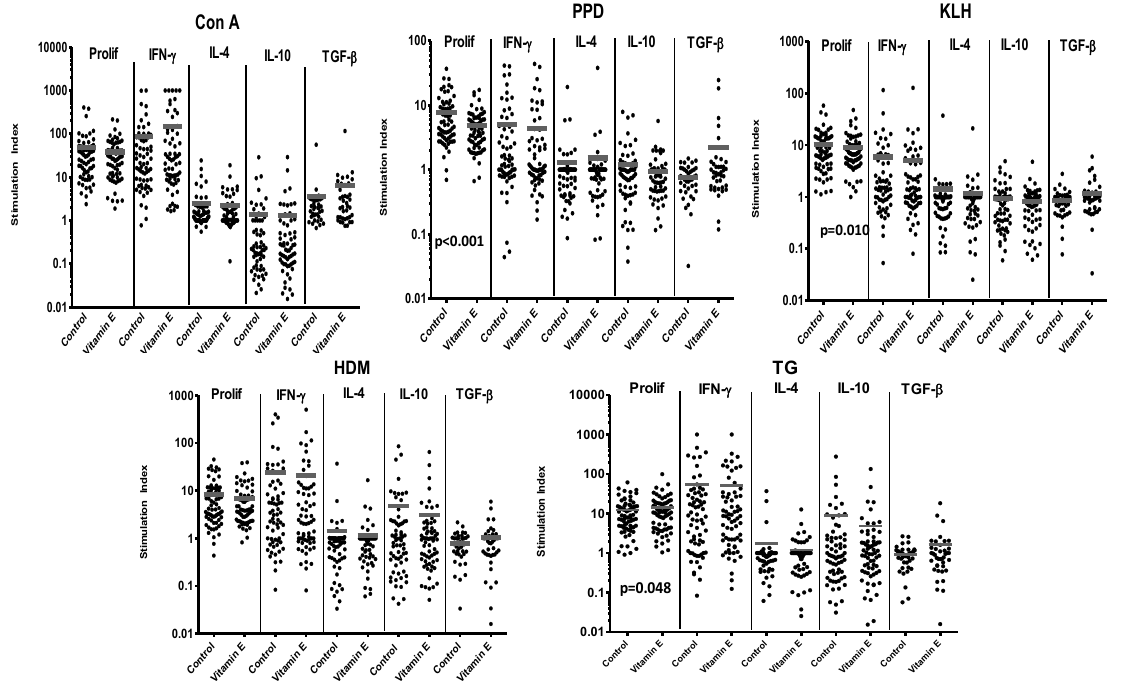
Figure 1. Responses of 70 cord blood mononuclear cell (CBMC) samples to control stimuli and allergens, with or without supplementation with vitamin E. Responses are expressed as stimulation index. Bars represent mean stimulation indices for each set of culture conditions. Significant p values for differences in responses between paired samples in cultures with or without vitamin E supplementation are shown on the relevant panels.